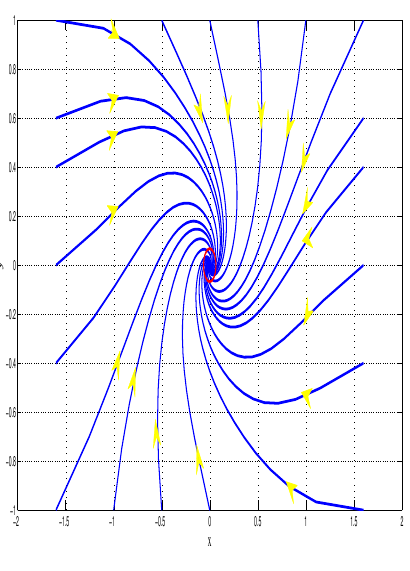
Figure 7. The numerical solutions generated by the NSFD scheme with h = 0 . 1 and t ∈ [0 , 100] in Example 4.